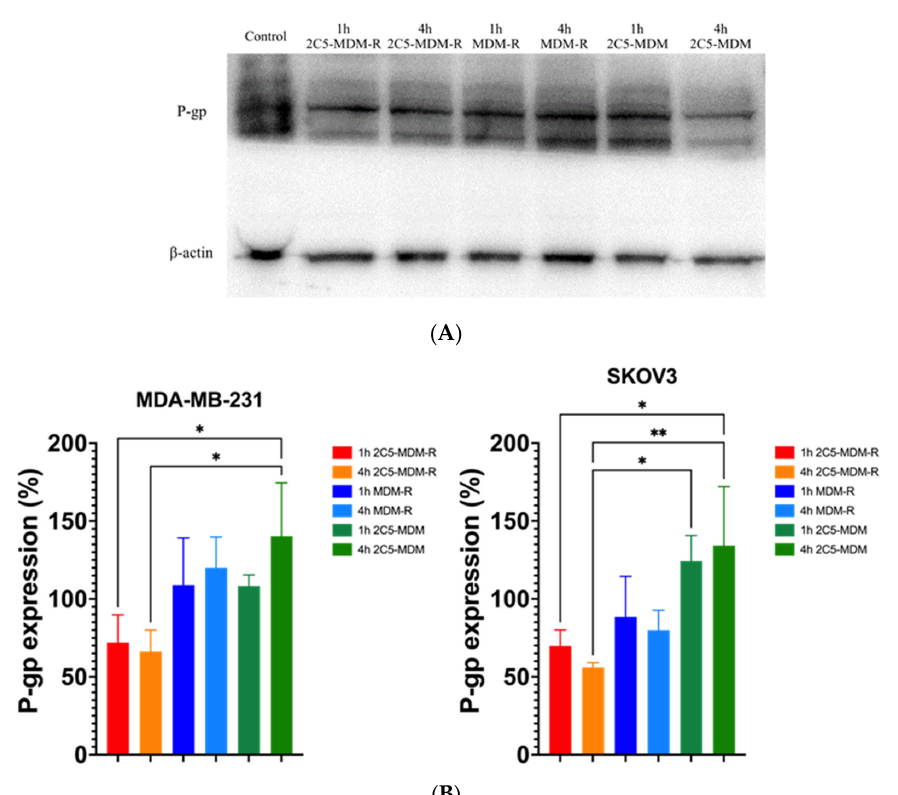
Figure 5. P-gp downregulation measured using Western blot; ( A ) representative Western blot gel image, ( B ) densitometry analysis with the 2C5-modified micelles in both MDA-MB-231 and Skov- 3TR cells. Results indicate ± SD ( n = 3), and significance was calculated with one-way ANOVA comparisons. ** p ≤ 0.01, * p ≤ 0.05.